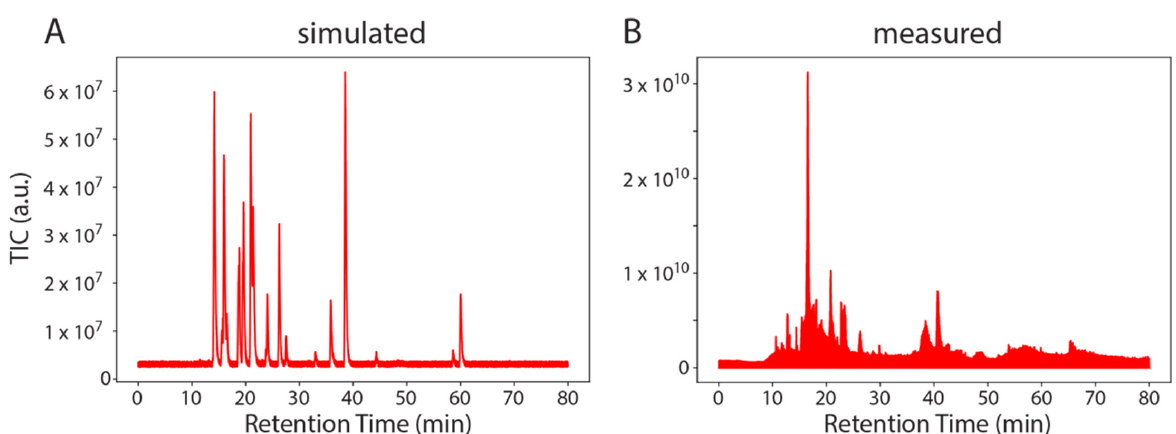
Figure 3. Example of SMITER output. Two total ion chromatograms (TIC): simulated ( A ) and measured ( B ) from a mix of modified nucleosides. Intensity is plotted on the Y-axis (a.u.) over the retention time (min).